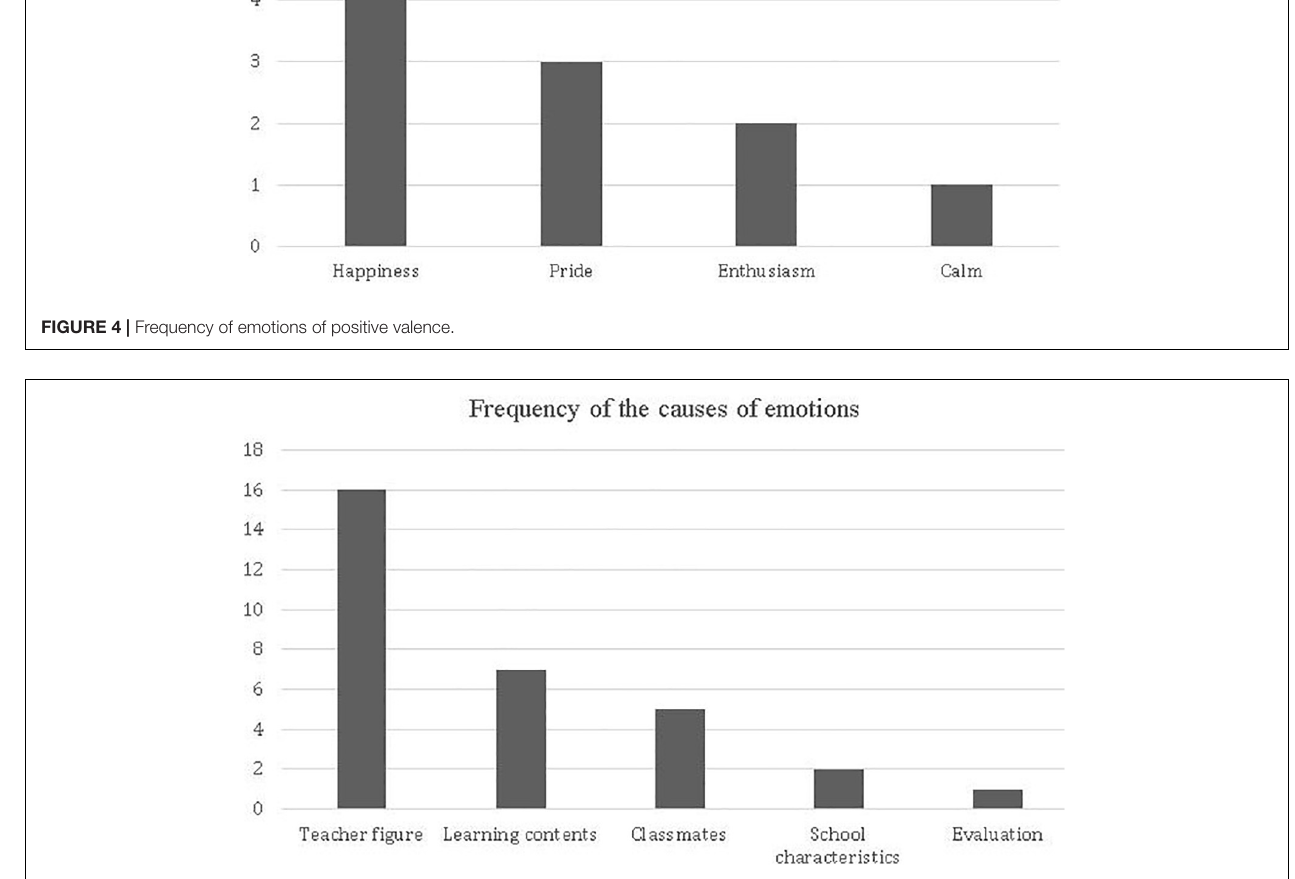
FIGURE 5 | Frequency of the causes of